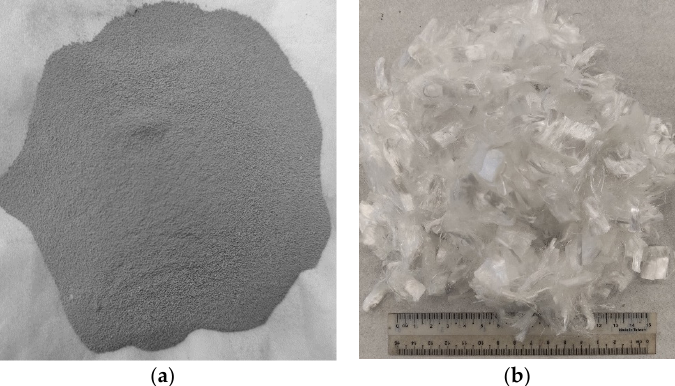
Figure 2. ( a ) Silica fume (SF) and ( b ) Polypropylene fiber (PPF) used in present research.